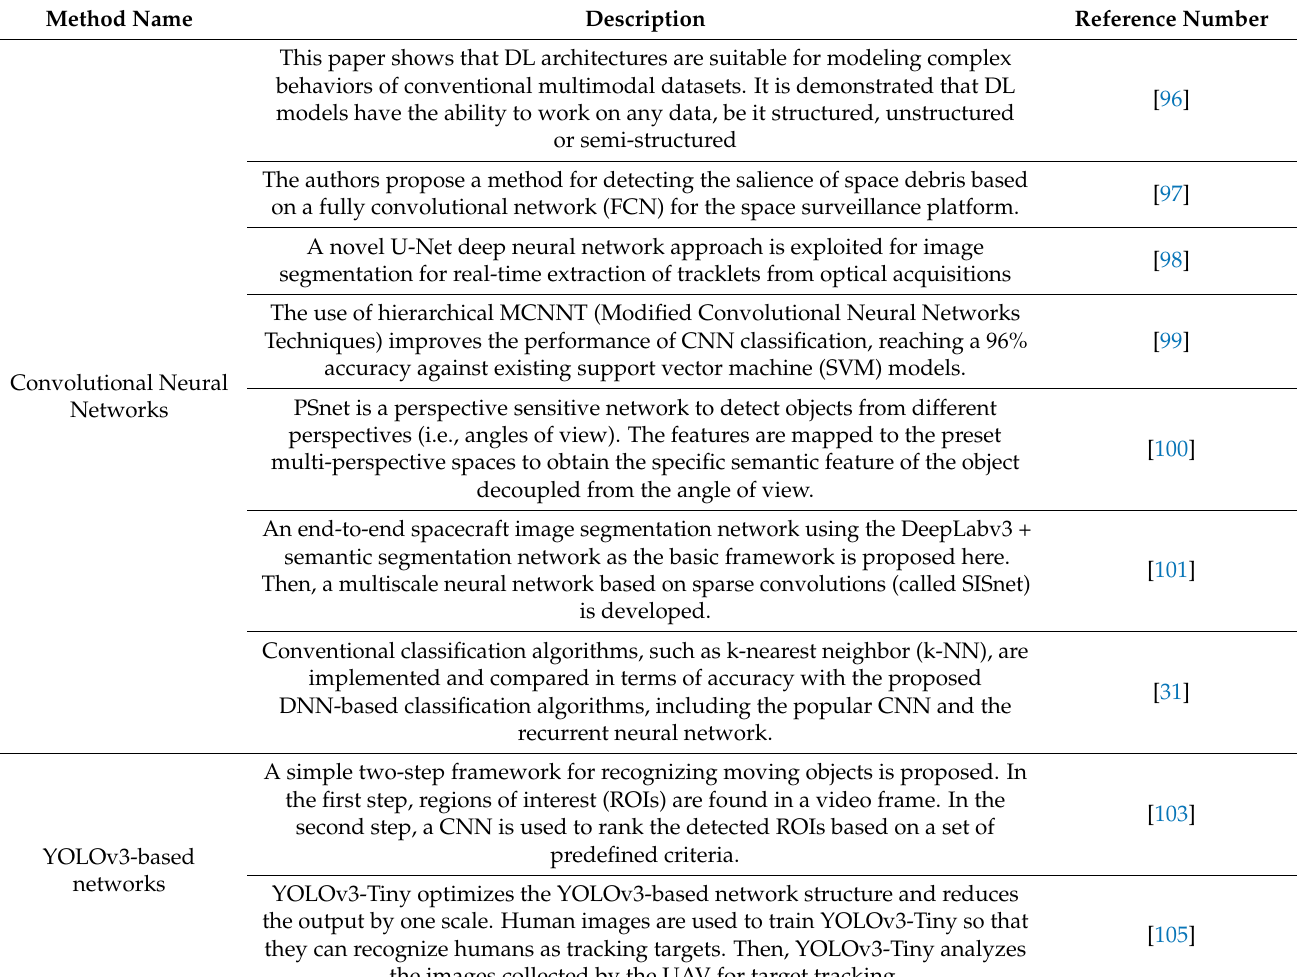
Table 2. DL-based methods for SSA space debris